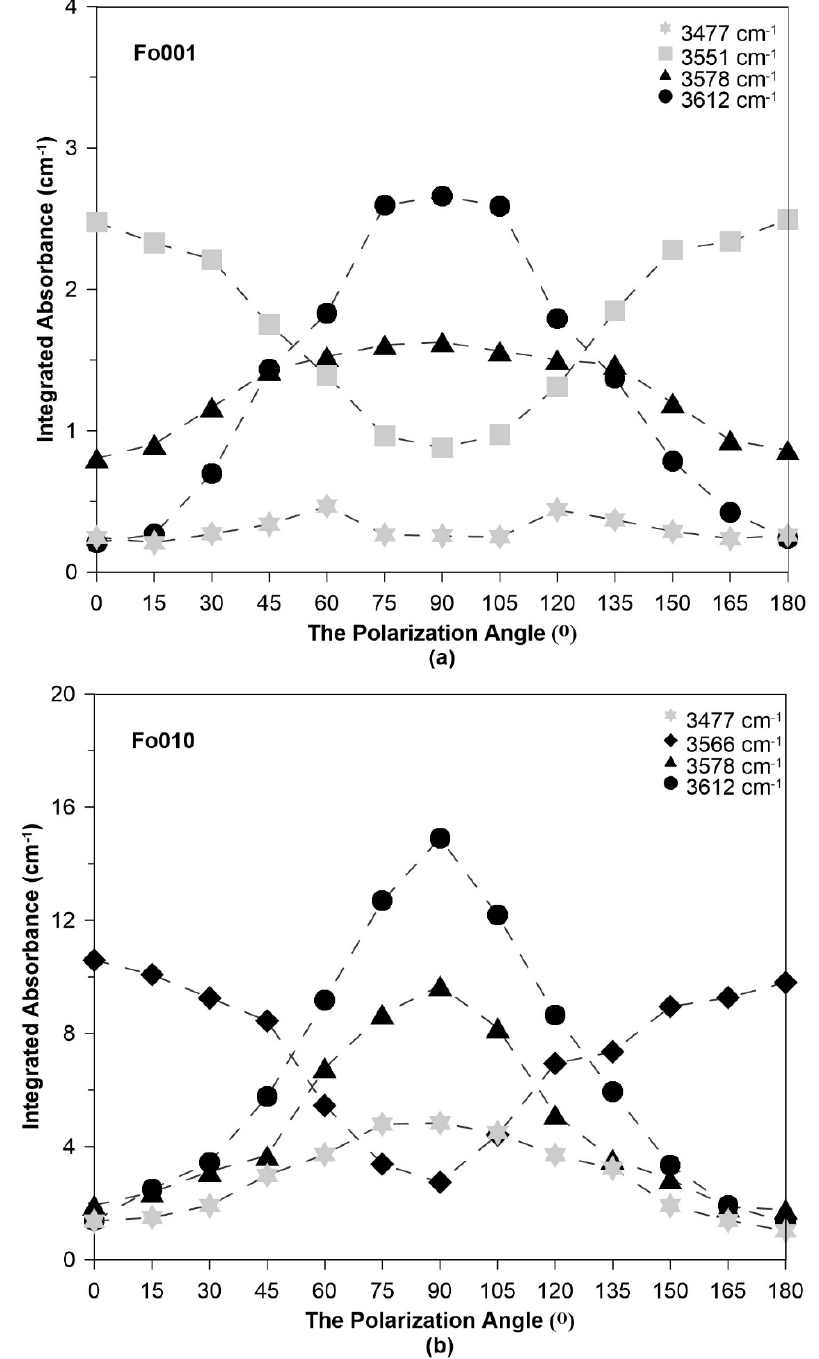
Figure 3. Variation of the integrated absorbances of the OH bands with the polarization angle for the oriented Fo001 ( a ) and Fo010 ( b ) samples. The angle of 90° is selected along a axis.